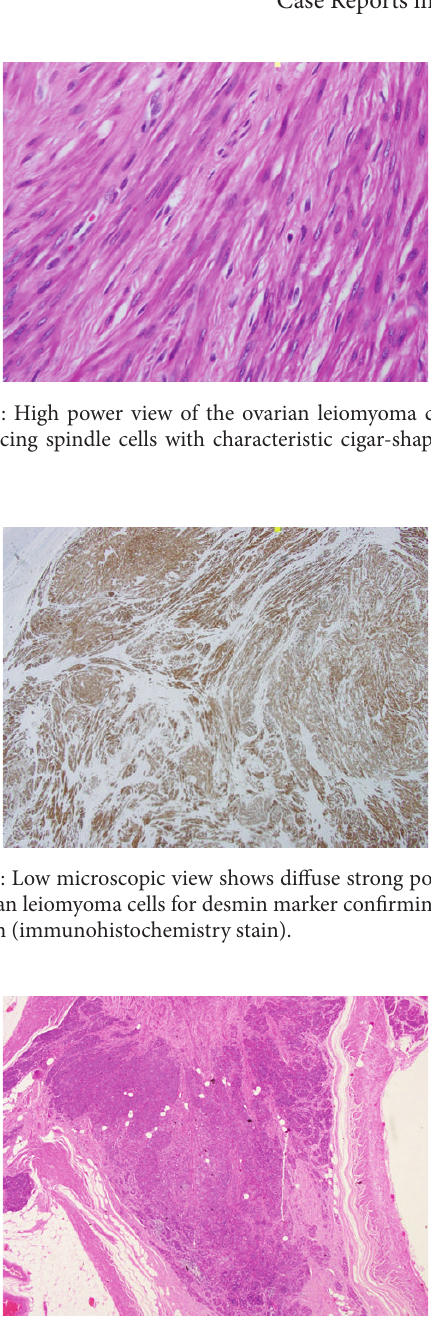
Figure 5: Low power microscopic view of the goblet cell carcinoid involving the entire wall to serosal level of the distal part of the appendix (H&E